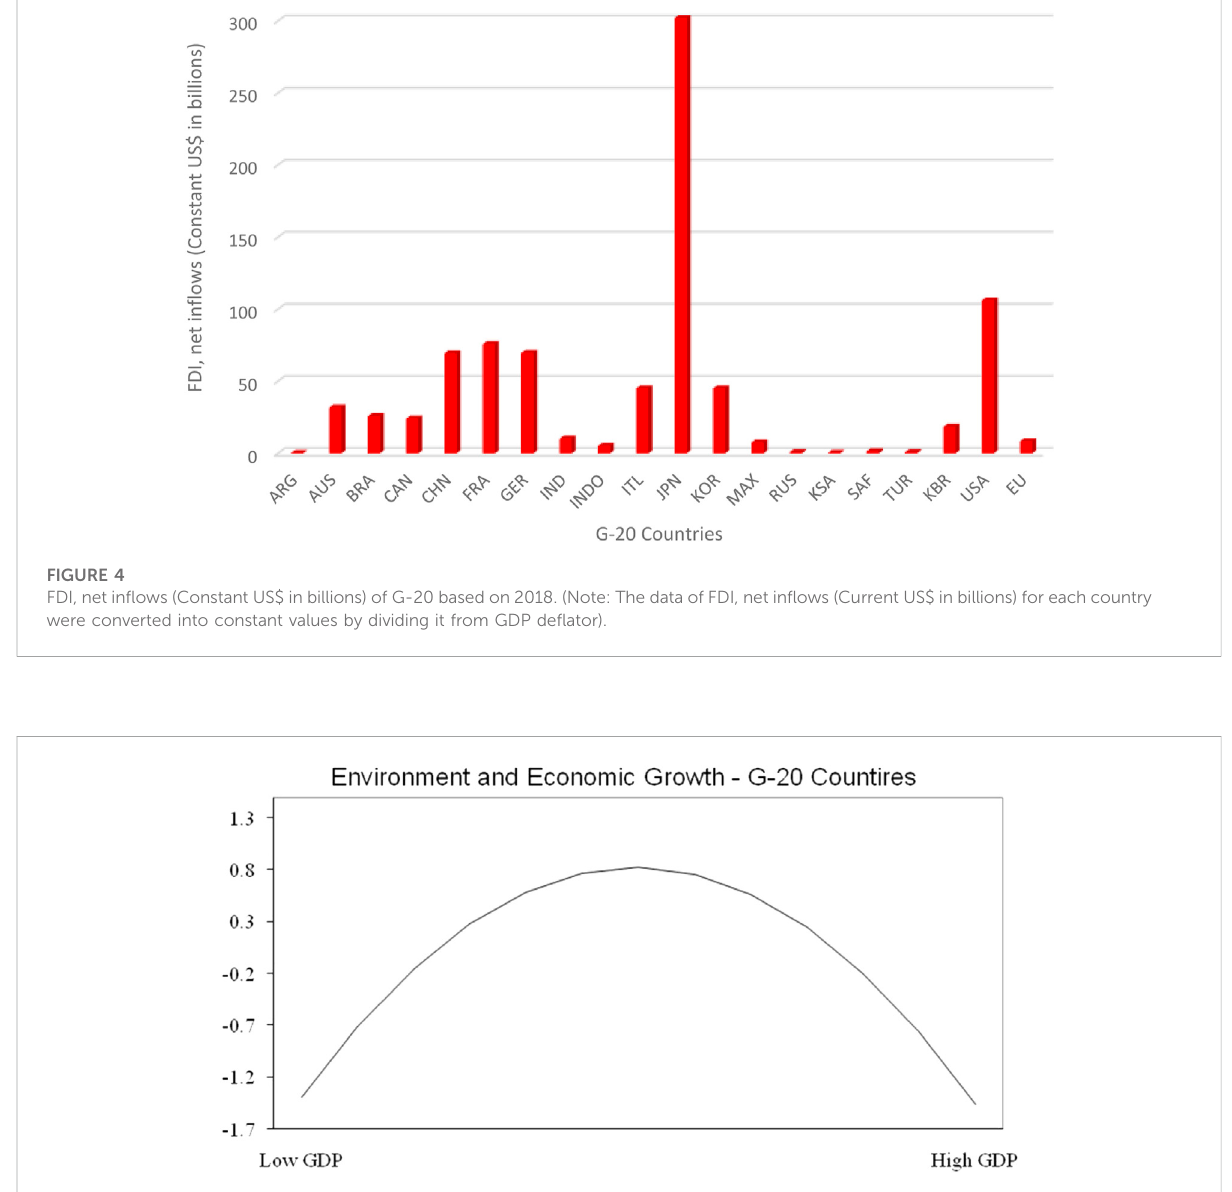
FIGURE 5 Environmental Kuznets Curve (EKC) hypothesis of G-20